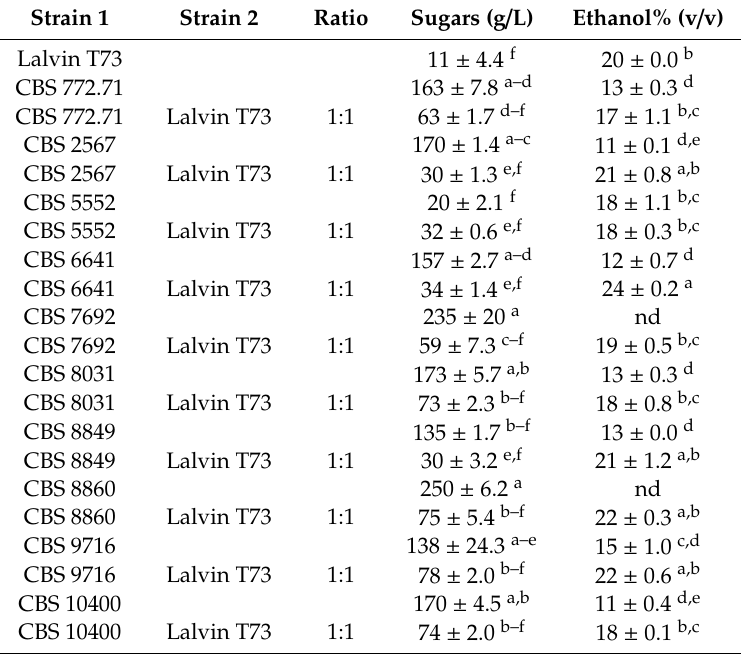
Table 3. Residual sugars and ethanol in the resulting